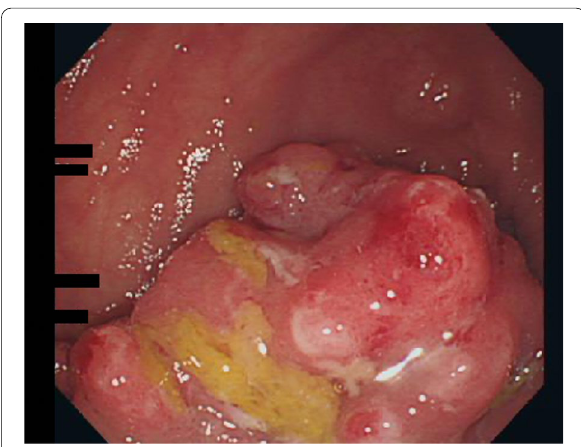
Fig. 1 Colonoscopy findings. Type 1 tumor in the sigmoid colon. A biopsy of the lesion reveals well-differentiated adenocarcinoma